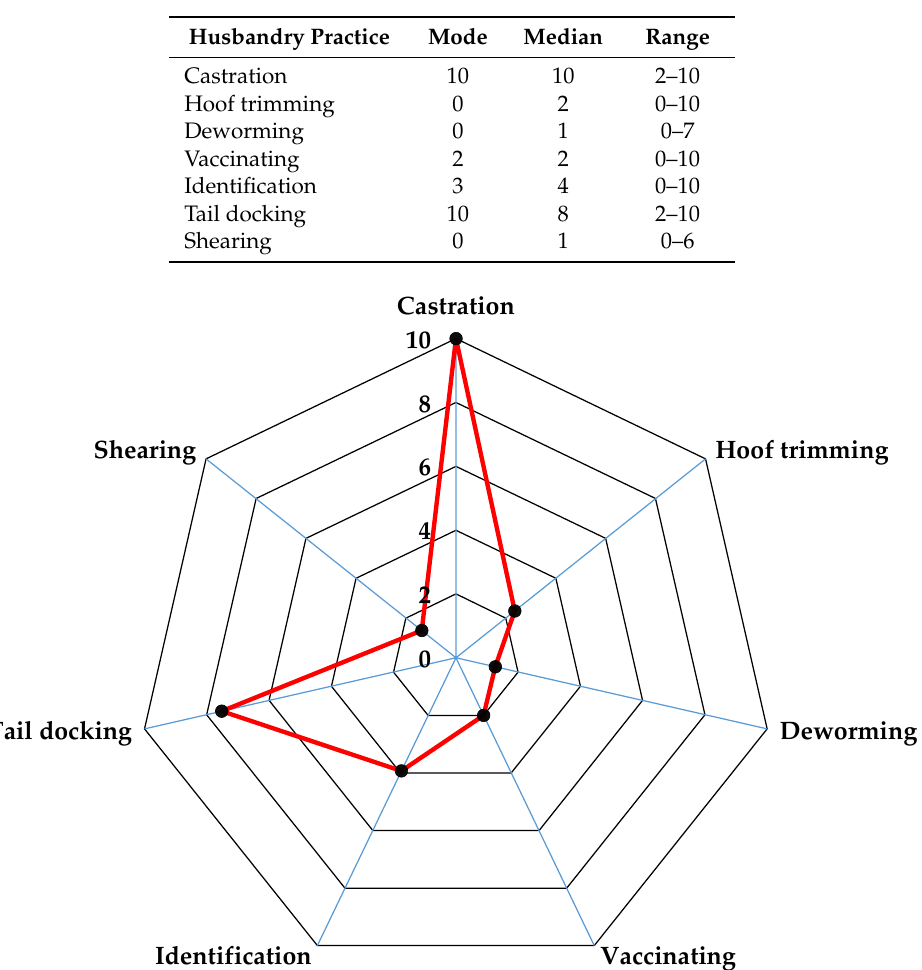
Figure 1. Median pain scores associated to husbandry practices in lambs using a numerical rating scale, from 0 (no pain) to 10 (maximum pain).